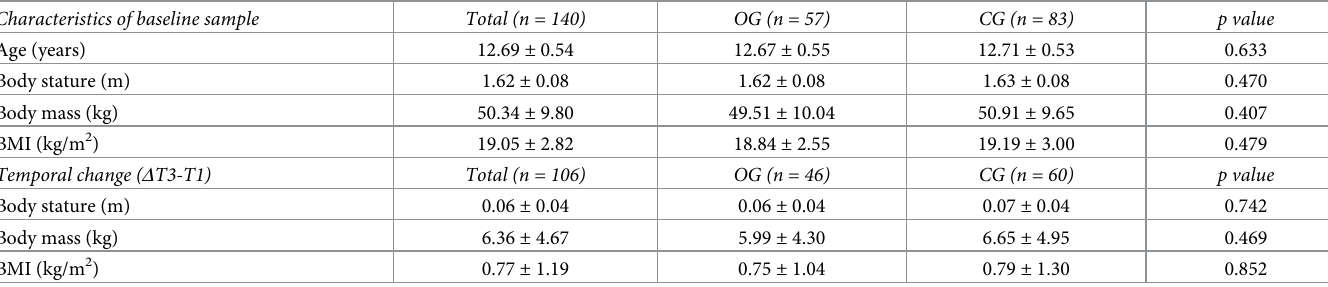
Data are expressed as means ± standard deviation or absolute numbers to determine differences between OG and CG independent t test and 1 chi 2 have been used; P < 0.050 was considered statistically